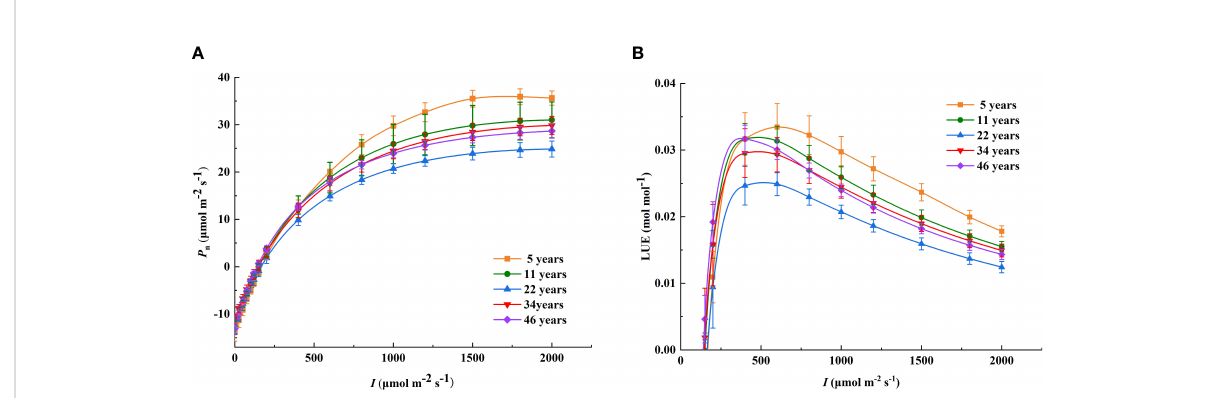
FIGURE 2 The light response curves of P n and LUE at different stand ages. (A) The light response curves of P n ; (B) the light response curves of LUE. The different colored lines show Haloxylon ammodendron with different stand ages. I , photosynthetic photon fl ux density; P n , net photosynthetic rate; LUE, light use ef fi ciency.